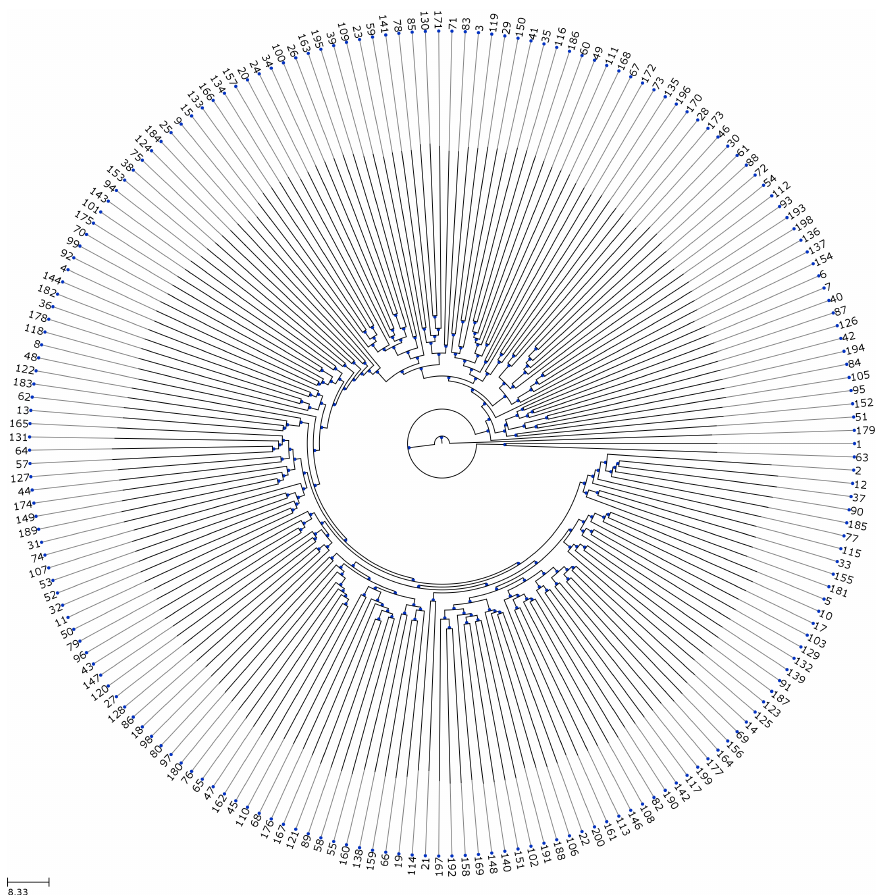
A dendrogram visualizing the distances between 200 structures. Comparison of the structures resulting from 200 simulations by displaying the pairwise root mean square deviation (paired RMSD) using a dendrogram. The leaves are marked with the simulation index. An inner node close to the root denotes high dissimilarity between the branches of the node. The presented tree reveals only inner nodes very close to the root. This leads to the conjecture that all structures are microscopically different, but macroscopically similar. Considering structure 179 as an outlier, this implies that the given model produces exactly one